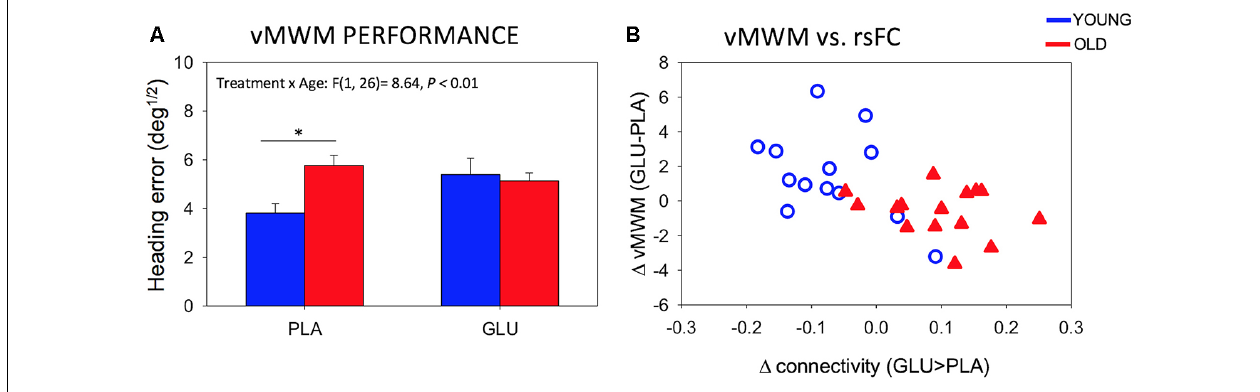
FIGURE 5 | (A) Behavioral performance on the vMWM task for younger and older subjects following placebo and glucose drink. Bars depict mean Heading error (deg 1/2 ; with SEM). Smaller values reflect better performance ∗ P < 0.05. (B) Scatterplot of change in rsFC of left posterior hippocampus to mPFC and change in performance on the spatial navigation task (heading error; r = − 0.56, P =